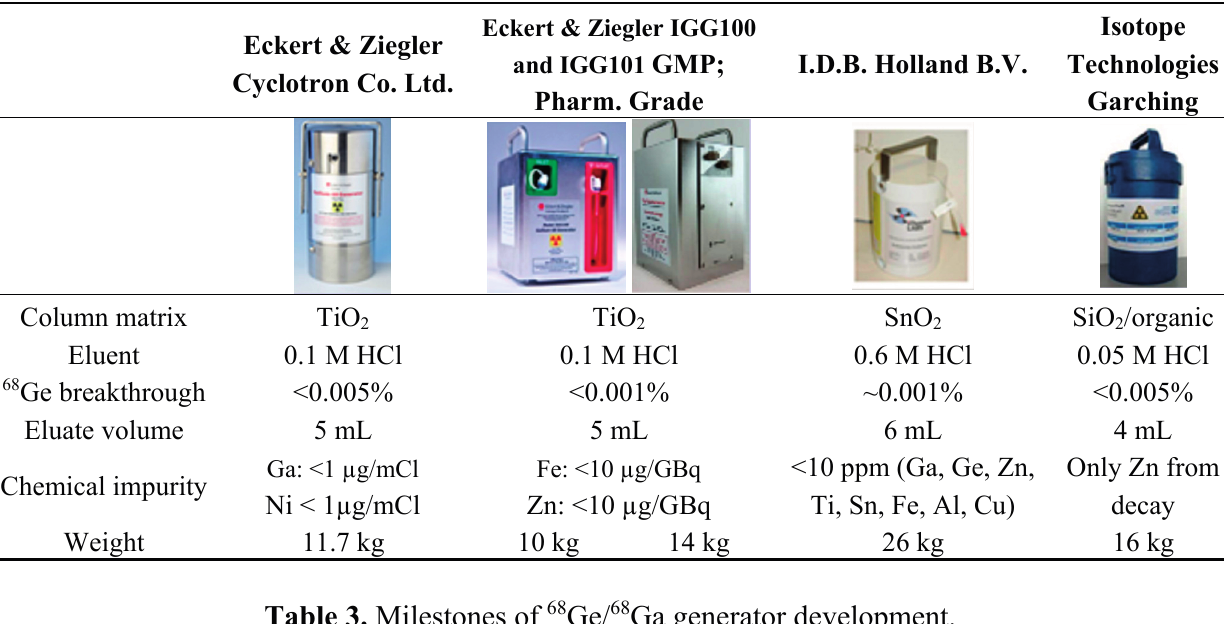
Table 2. Examples of commercial 68 Ge/ 68 Ga generators.